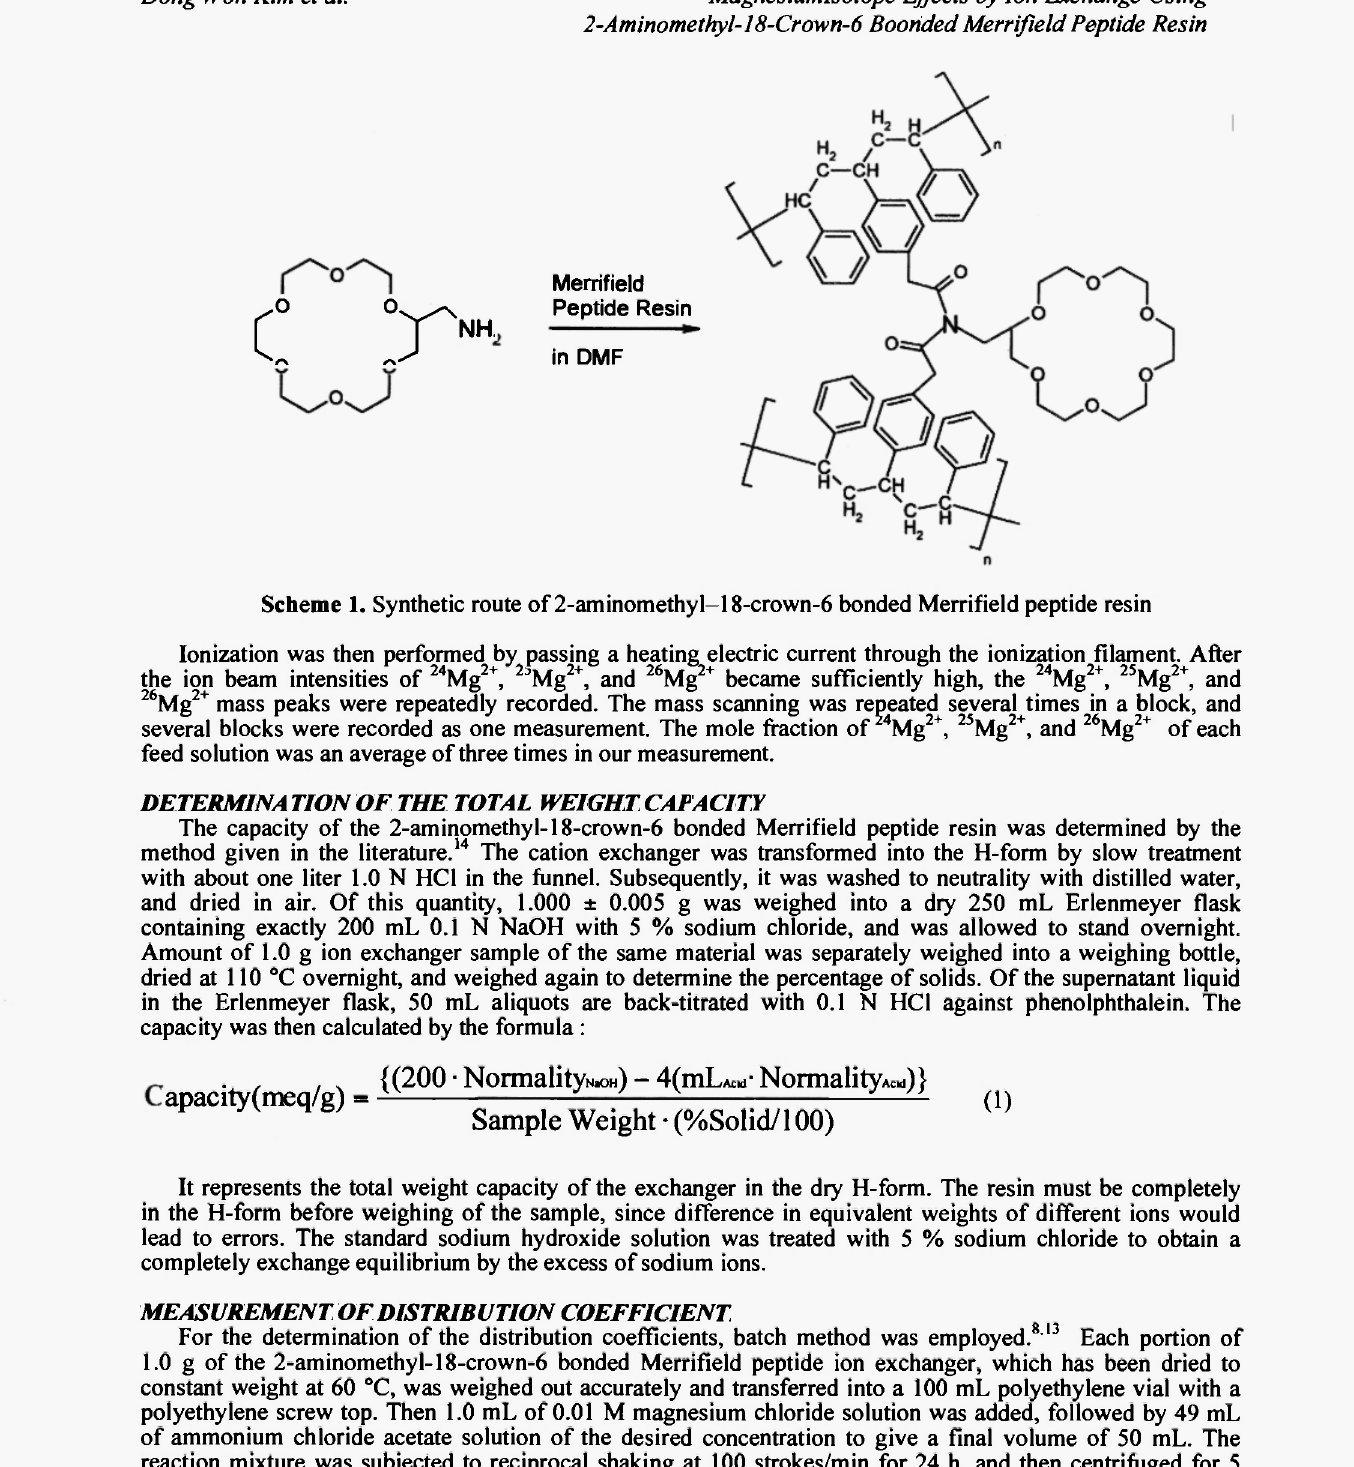
MEASUREMENT OF DISTRIBUTION COEFFICIENT For the determination of the distribution coefficients, batch method was employed. 8 ' 13 Each portion of 1.0 g of the 2-aminomethyl-18-crown-6 bonded Merrifield peptide ion exchanger, which has been dried